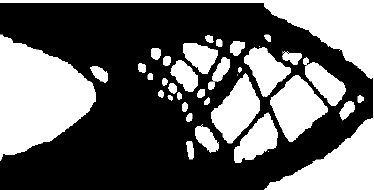
Figure 8. Cantilever beam design using both reference inputs from Figure 3; Compliance: